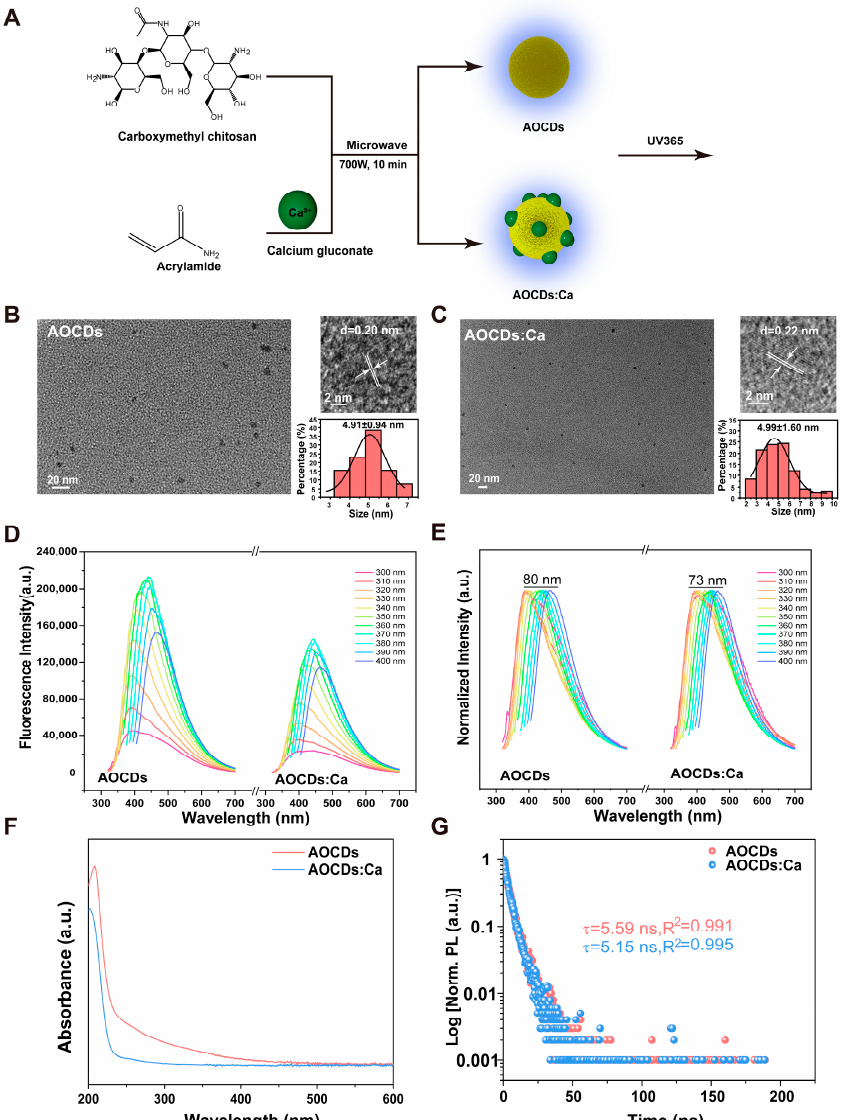
Figure 2. Particle size and luminescence characteristics of CDs. ( A ). The synthetic route of AOCDs and AOCDs:Ca, ( B ). AOCDs particle size and ( C ). AOCDs:Ca particle size detection by TEM, The lines mark the adjacent diffraction peaks and indicate them with arrows ( D ). AOCDs and Ca @ AOCDs fluorescence emission spectra, ( E ). AOCDs and AOCDs:Ca wavelength redshift, ( F ). UV absorption spectra, ( G ). Fluorescence lifetime.